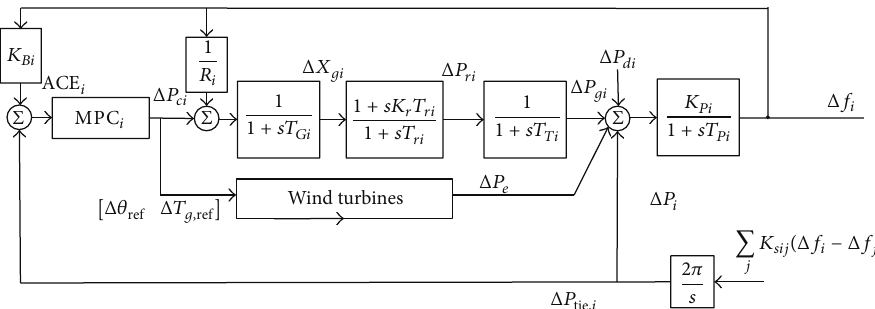
Figure 2: Block diagram of a thermal power plant and wind turbines ( 𝑖 = 1 ).